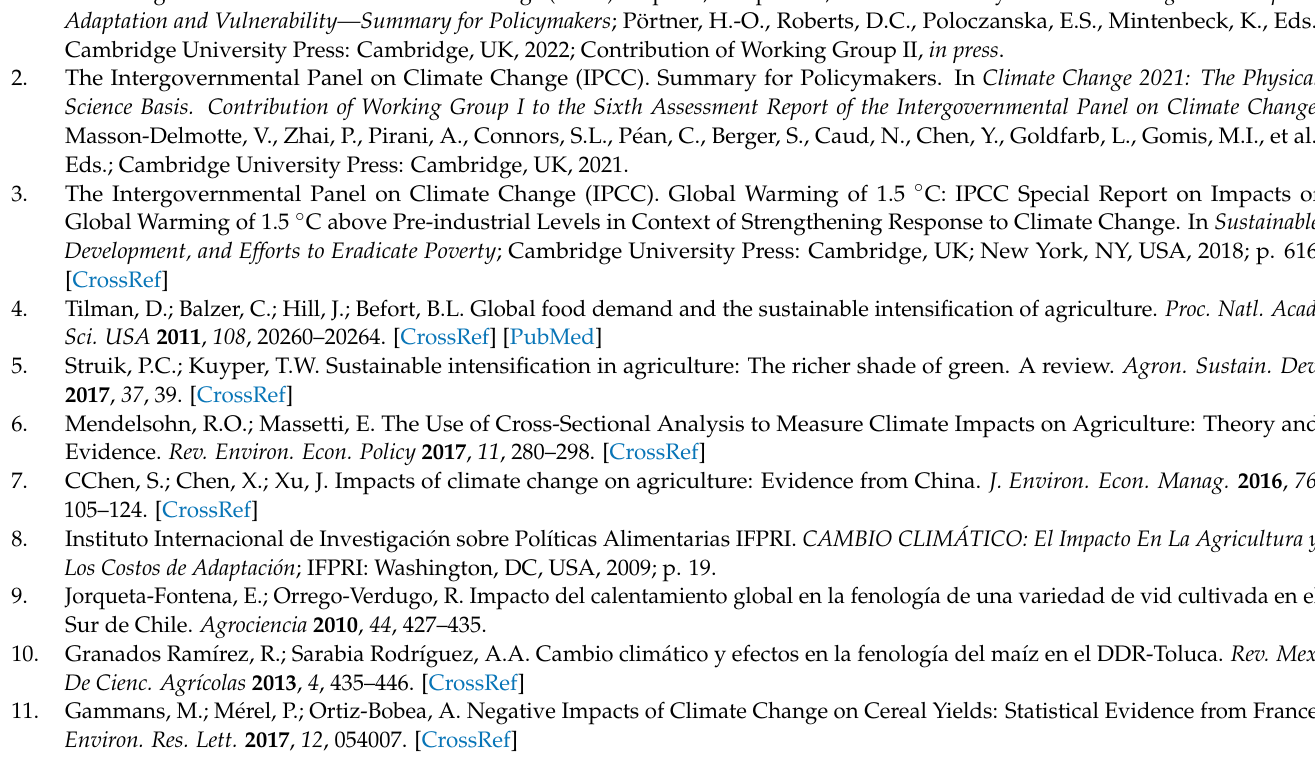
Table S1: Agricultural producers type identified by the authors; Table S2: Synthesis of the studies selected and analyzed for assessing the capacity to adapt to climate change; Table S3: Definition of terms used in the